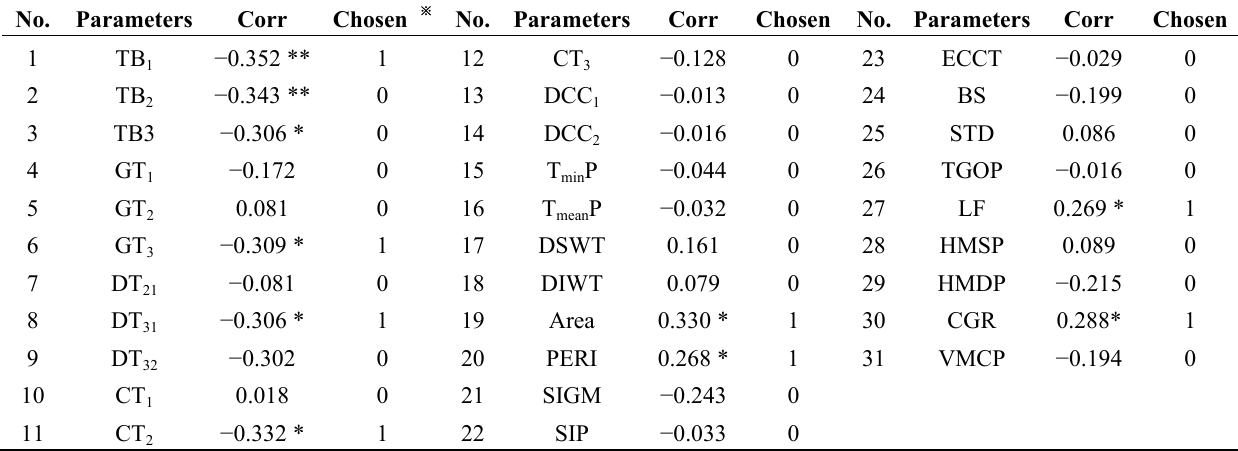
Table 4. The correlation coefficient (Corr) of the rain rate and cloud